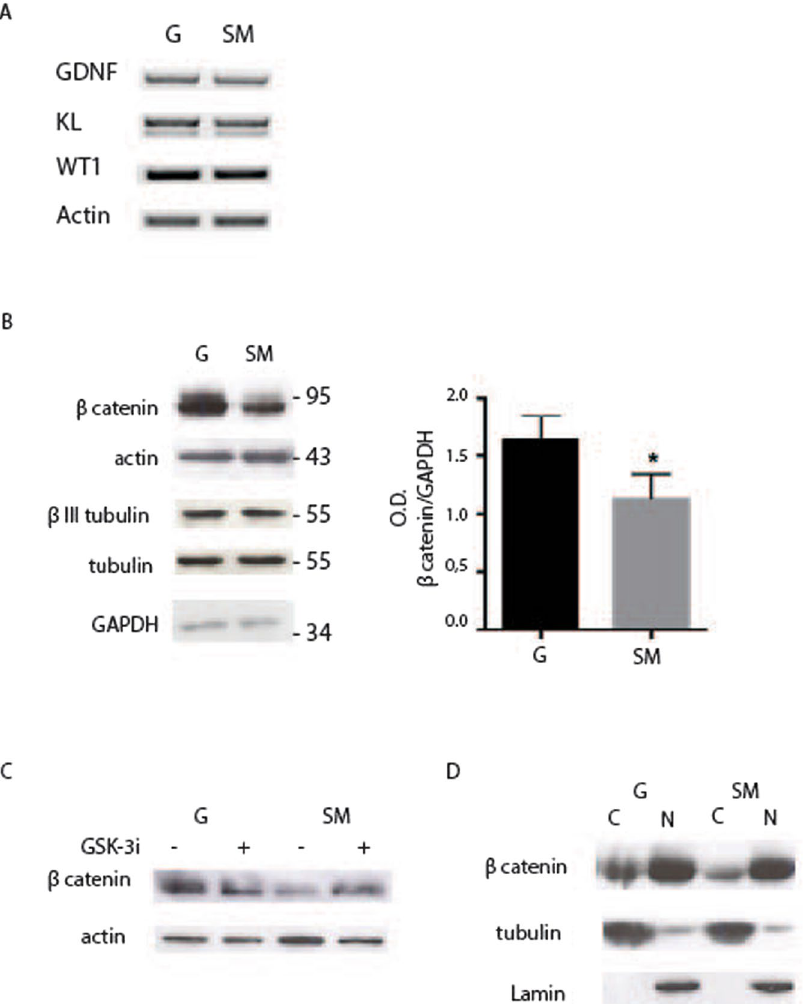
Figure 3. Microgravity causes a decrease in β -catenin protein expression. ( A ) Semiquantitative–PCR analysis of growth factors GDNF and KL in Sertoli cells cultured for 48 h at G or under SM. ( B ) Western blot analysis of cytoskeletal proteins in extracts from Sertoli cells cultured for 48 h at G or under SM. Densitometric analysis of β -catenin is reported on the right showing a decrease in the protein level under SM. ( C ) Western blot analysis of β -catenin in extracts from Sertoli cells cultured for 48 h at G or under SM, in the presence or not of GSK-3 β inhibitor CHIR 99021. Treatment inhibits degradation of β -catenin caused by SM. ( D ) Western blot analysis of β -catenin distribution in the nuclear (N) and cytosolic ( C ) fractions of Sertoli cells cultured for 48 h at G or under SM. At least three different experiments were performed. Bars represent s.d. Asterisks indicate: * P <